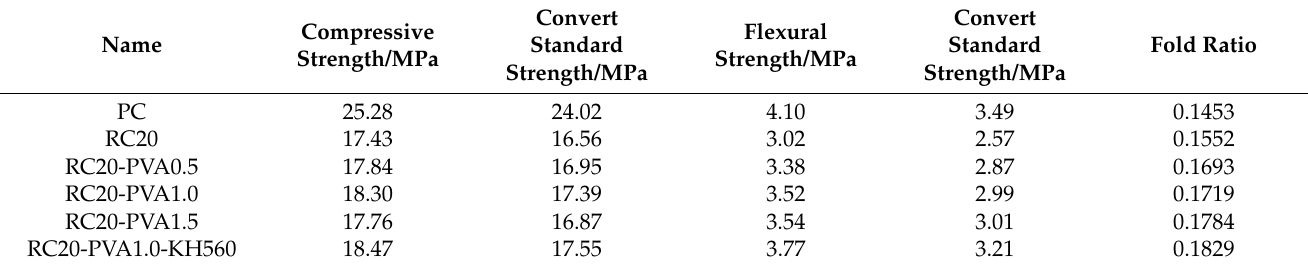
Table 6. Compressive and flexural strength of PVA fiber rubber concrete under different